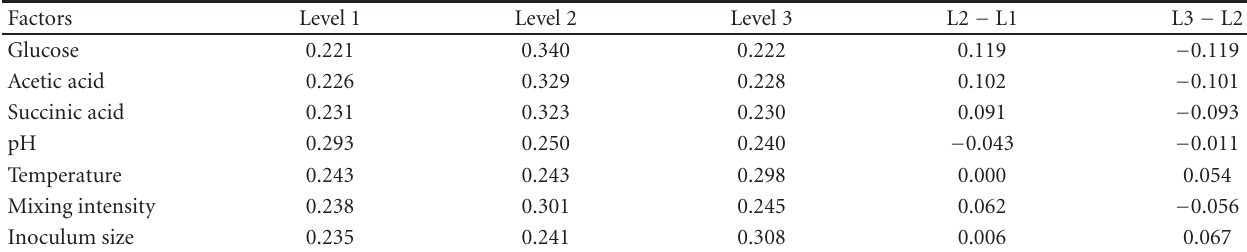
Table 3: The main e ff ects of the factors at the assigned levels on 2,3-butanediol